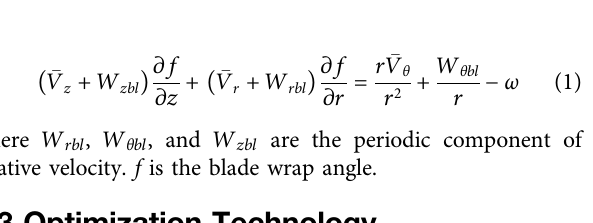
FIGURE 3 | Grid of the computational domain with whole fl ow